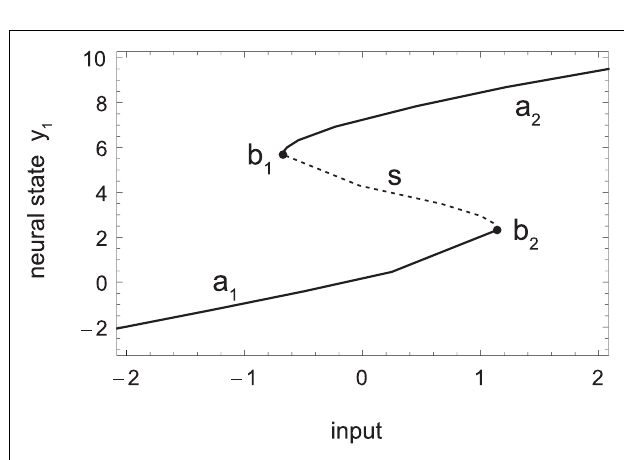
FIGUREA1 | Evolved performance . Left: fitness of the evolved agent for approach behavior with single bell shapes of varying width and height. Higher (brighter) values are better, zero being the maximum fitness. Horizontal bars indicate the range of shapes encountered during evolution